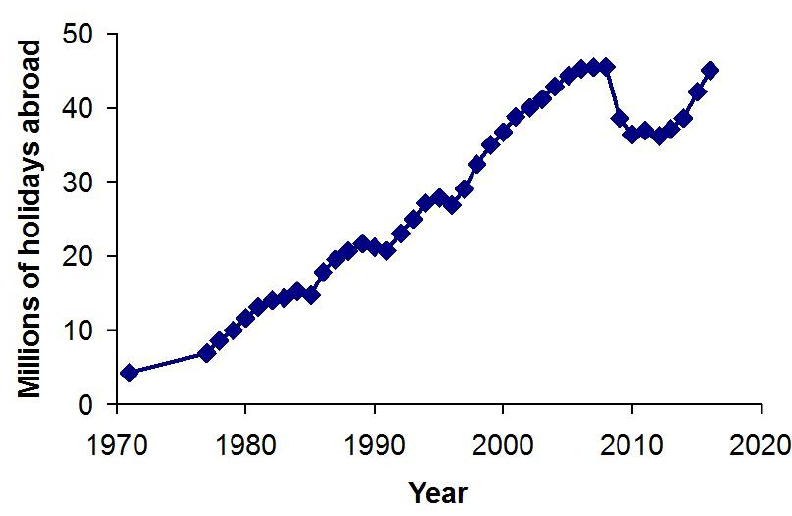
Figure 8. Holidays abroad taken by UK residents in the period 1971–2016 [12].